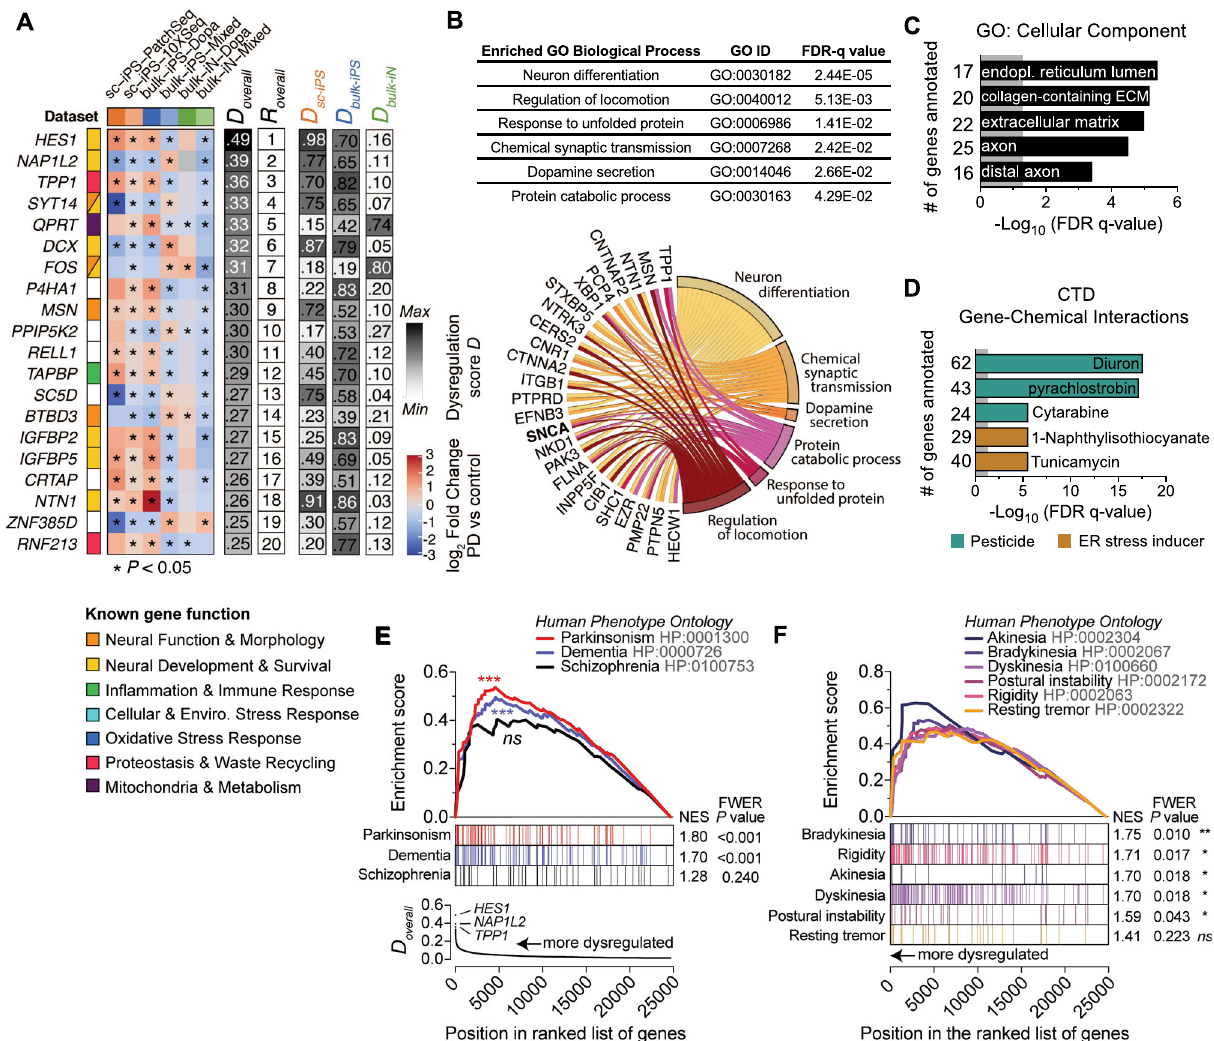
Fig. 3 Integrative analysis of multiple transcriptomics datasets reveal Parkinson ’ s disease-related gene signatures and biological processes in patient-reprogrammed neurons. A Heatmap of mean log2 fold changes in expression of the top 20 genes with the highest dysregulation across all six datasets of PD versus control reprogrammed neurons. Red and blue indicate, respectively, up- and downregulation in PD cells relative to control. Gene function and overall dysregulation score ( D overall ) are annotated vertically according to the legend. D sc-iPS , D bulk-iPS and D bulk-iN scores indicate the strength of dysregulation for, respectively, the two single-cell iPSC neuron datasets ( orange ), the two bulk iPSC neuron datasets ( blue ) and the two bulk iN datasets ( green ) (see Methods for details). *, nominal P combined < 0.05. B , C , D ToppFun functional enrichment analysis of the 200 most highly dysregulated genes across all datasets highlights fundamental biological processes ( B ), cellular components ( C ) and chemicals ( D ) implicated or suspected to be involved in PD. Chord plot in ( B ) indicates genes annotated to dysregulated GO biological processes, ordered by decreasing overall dysregulation score. Length of bars in ( C, D ) represent Benjamini- Hochberg-corrected signi fi cance values and numbers indicate number of genes annotated to GO term; grey color indicates signi fi cance threshold. Extended data in Supplementary Tables 4 and 5. E Gene Set Enrichment Analysis (GSEA) of multiple-dataset PD dysregulated genes for genes associated with the terms “ Parkinsonism ” , “ Dementia ” and “ Schizophrenia ” from the Human Phenotype Ontology (HPO) database 131 . “ Parkinsonism ” - and “ Dementia ” -related genes were signi fi cantly overrepresented at the top of the list of expressed genes ( n = 24,693) rank- ordered by decreasing